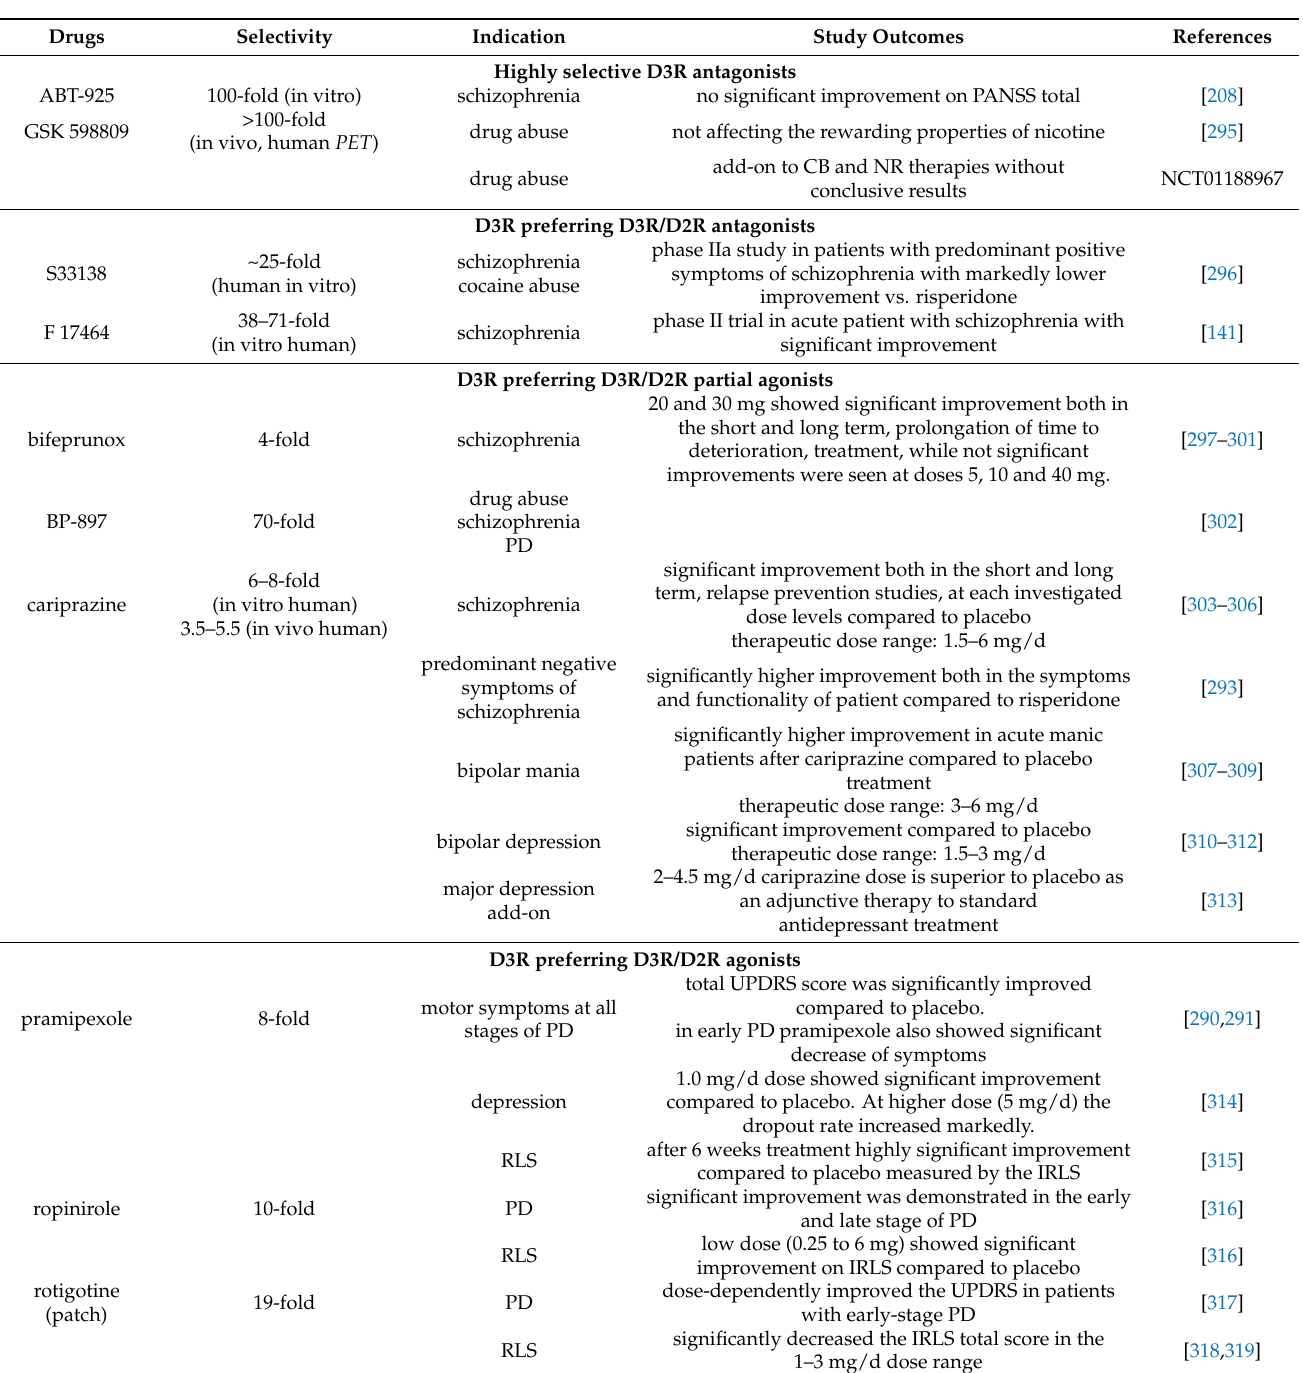
Table 7. Overview of clinical trials on the D3R acting